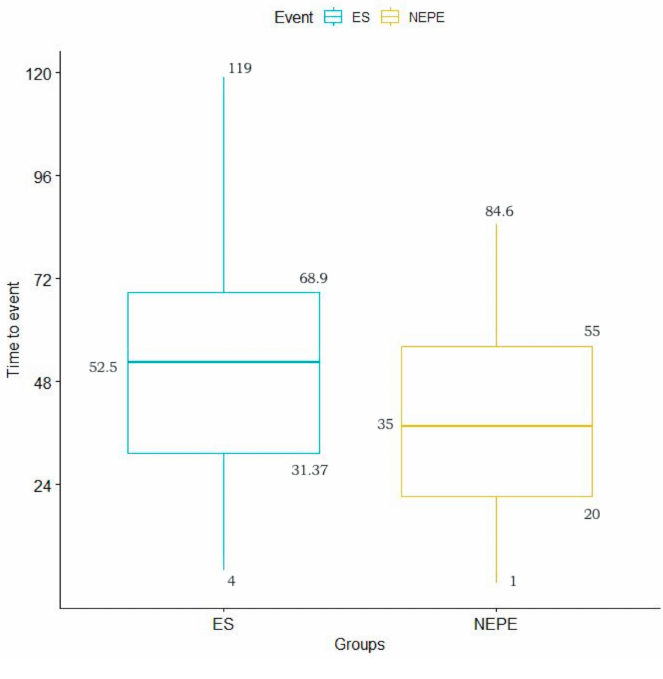
Figure 4. Average time of appearance of the total recorded events for PNES and ES.